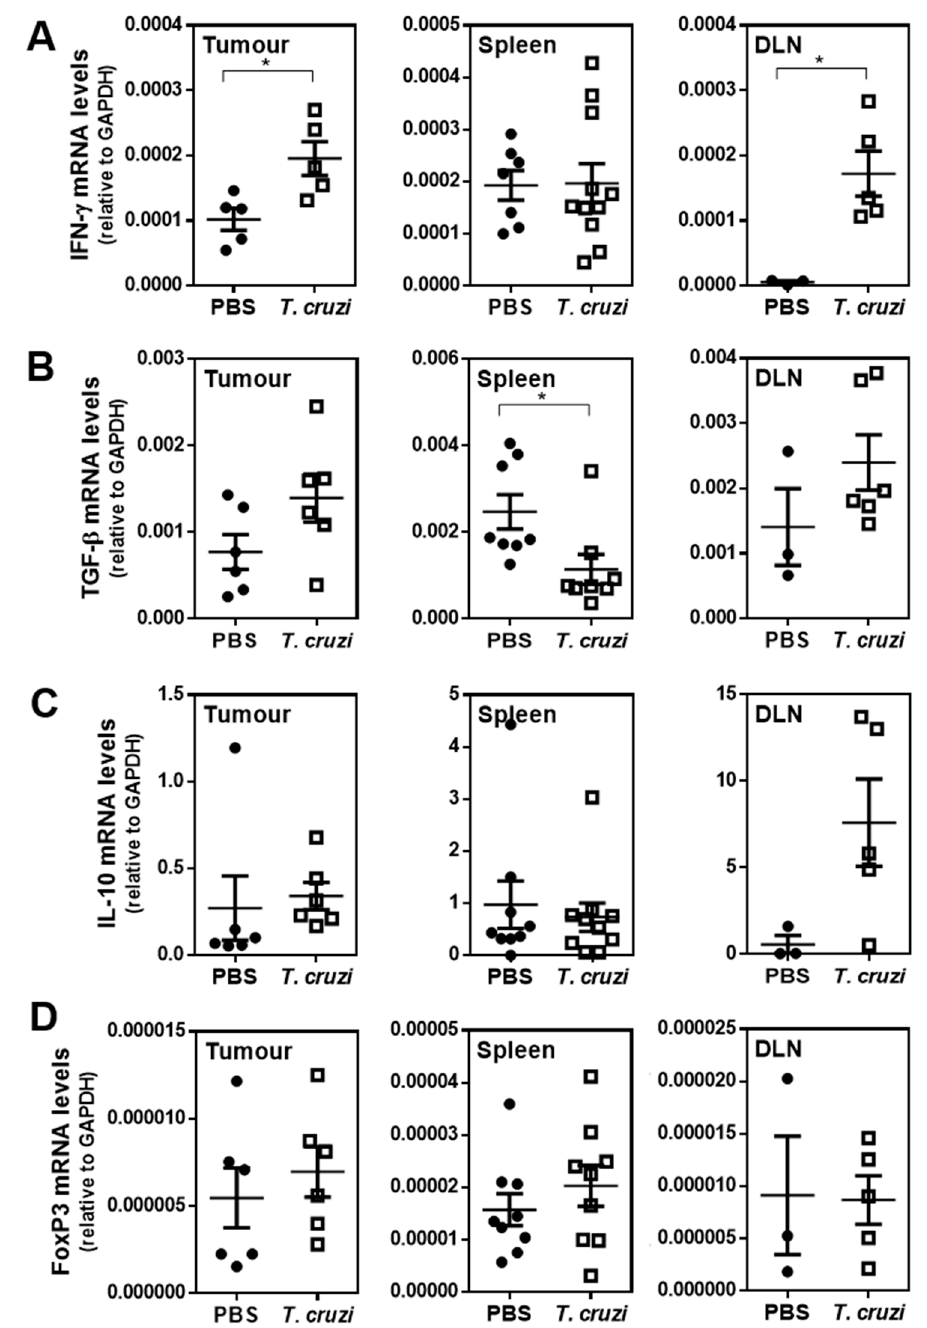
in the induction of tumour protection.